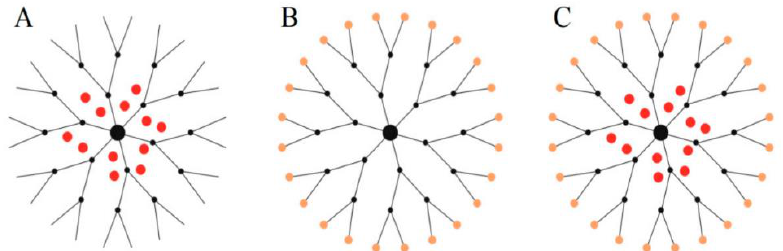
Figure 3. Schematic illustration of the three ways of complexation or conjugation of anti-cancer drugs with a dendrimer molecule. ( A ) Encapsulation of the chemotherapeutic into the internal cavity, ( B ) surface conjugation of chemotherapeutic onto the peripheral of the dendrimer molecule, and ( C ) same dendritic molecule can serve a carrier for both encapsulated and surface-conjugated anti-cancer drugs. Adapted and modified with permission from [71].